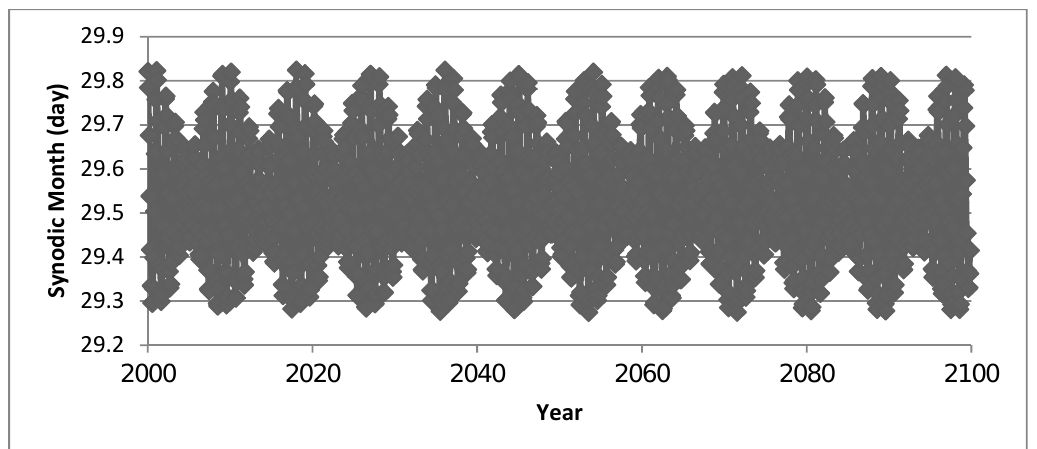
Fig.2: Period of the synodic month through 2000-2100.